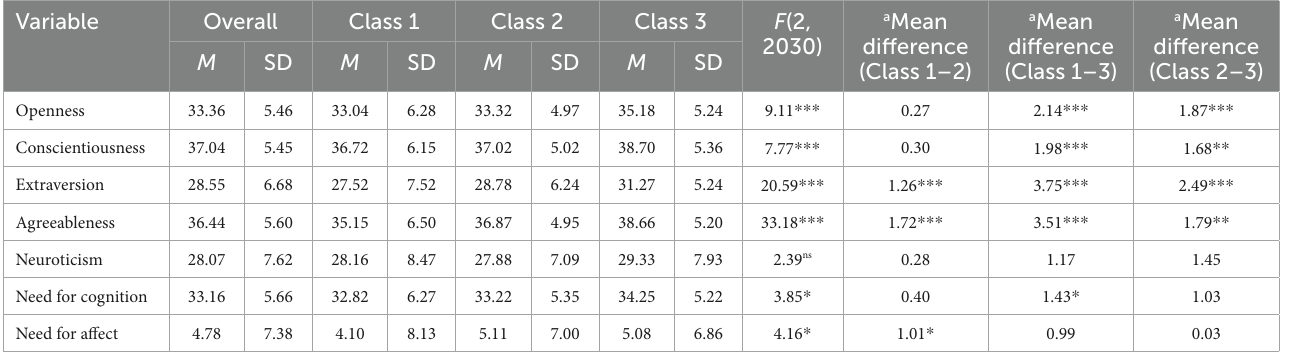
TABLE 3 Differences in big five personality traits and information processing styles. Variable